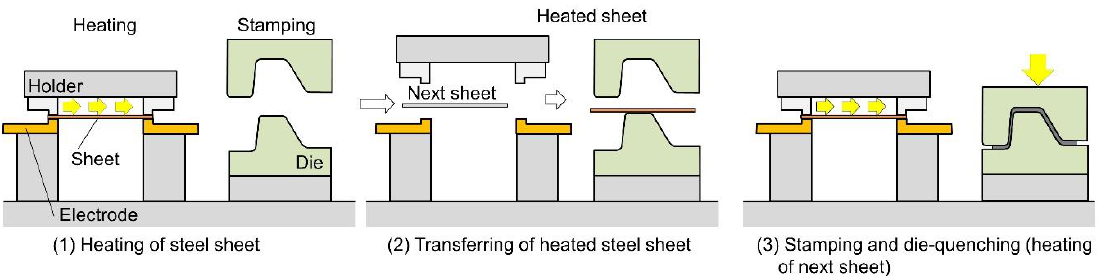
Figure 1. Hot stamping having simultaneous heating of next blank with the die quenching.